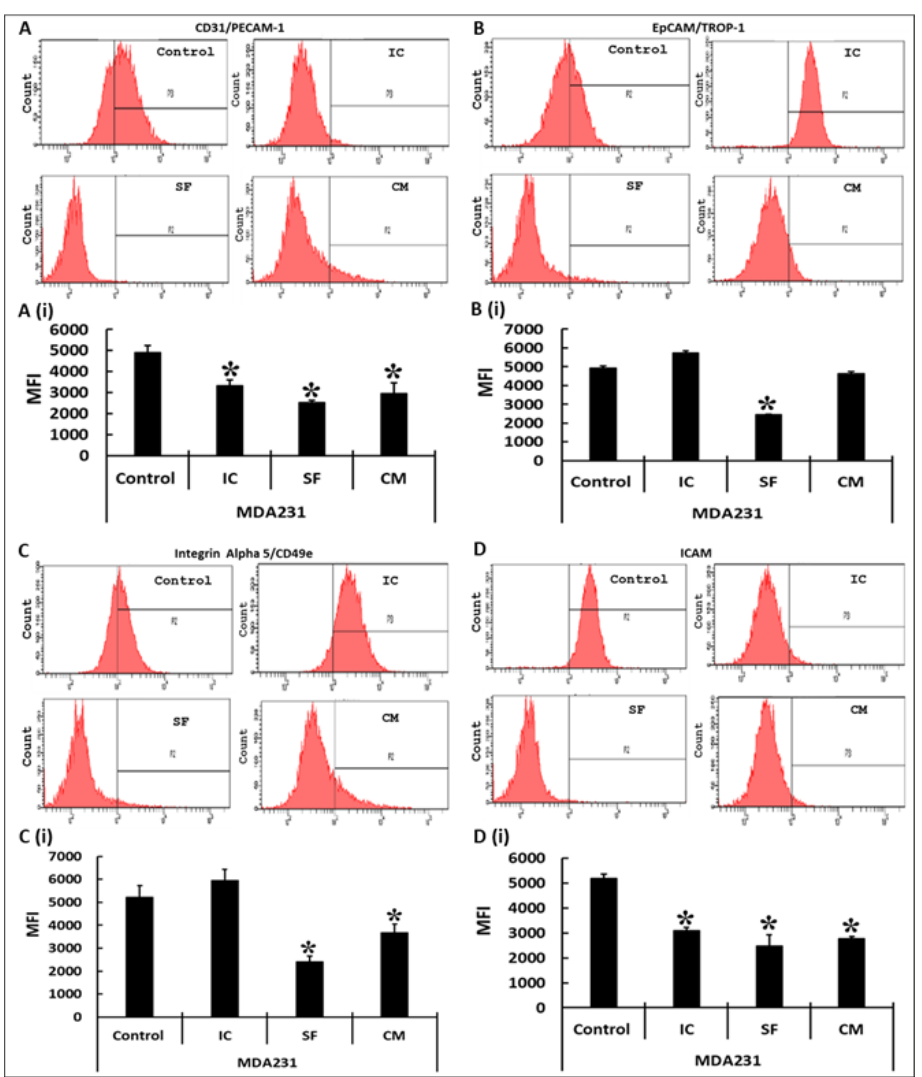
Figure 5. Effect of DPMSCs on MDA231 cell expression of adhesion molecules. Flow cytometry analysis of the adhesion molecules performed on DPMSC-treated MDA231 cells or untreated con-